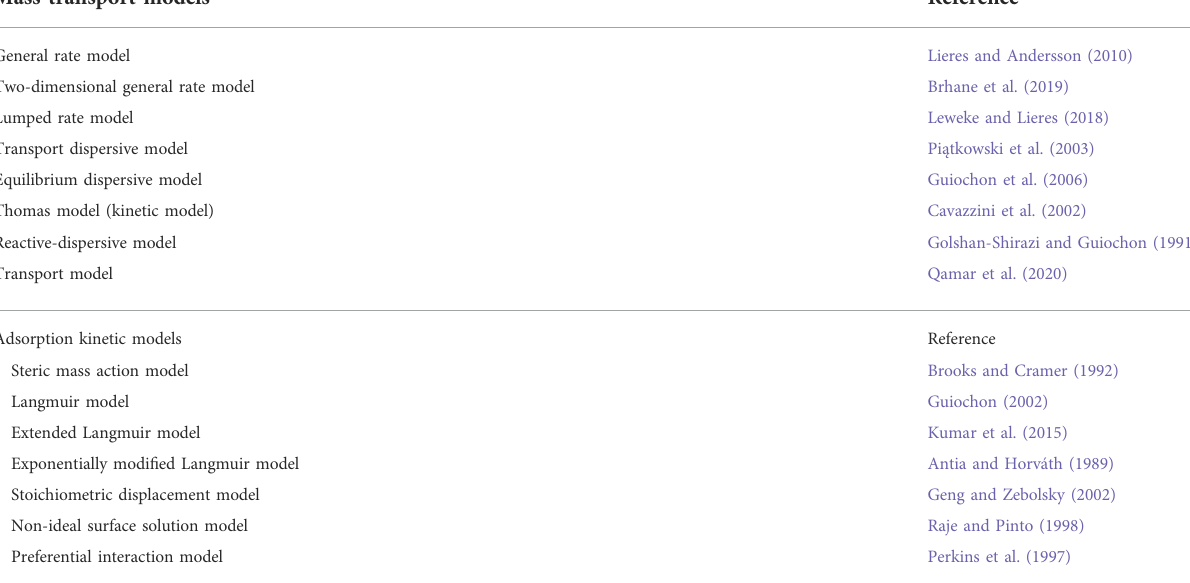
TABLE 1 List of mass transport models and adsorption kinetic models for the mechanistic modeling of the protein transport and adsorption during chromatography-based puri fi cation